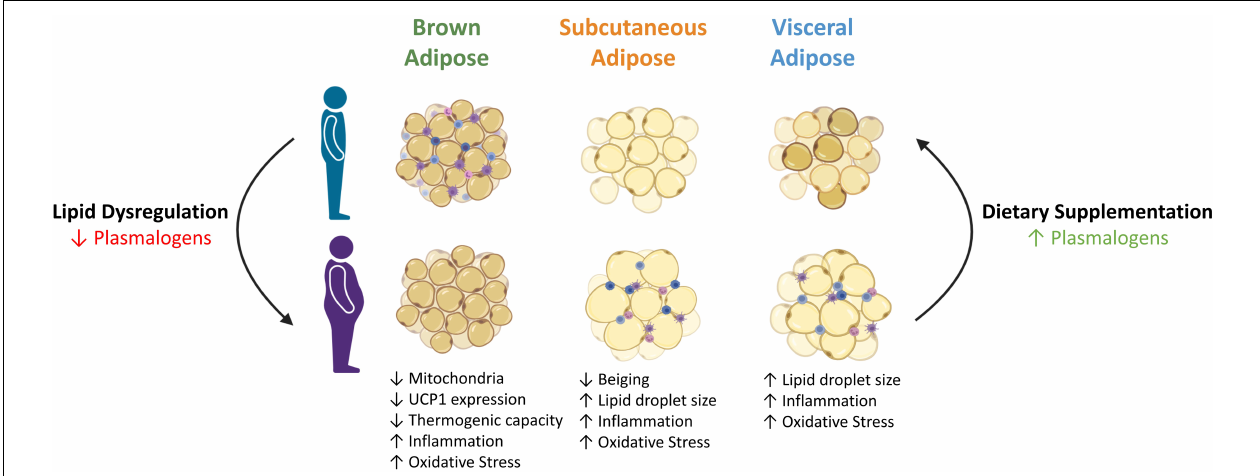
FIGURE 3 | Possible role of plasmalogens in adipose tissue metabolism and function in the setting of obesity. Obesity is characterised by enlarged adipocytes and severe lipid dysregulation, including reduced plasmalogens. Decreased plasmalogen levels impedes the normal function and size of adipocytes, further exacerbating the metabolic complications associated with obesity. Conversely, increasing plasmalogen levels via dietary supplementation appears to revert the effects of obesity on adipocytes by restoring their size and function. UCP1, uncoupling protein 1. Created with Biorender.com